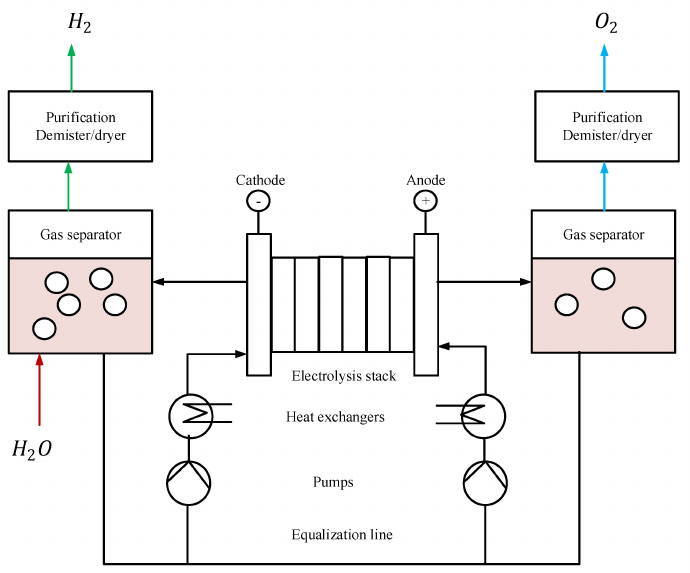
Figure 5. The alkaline water electrolyzer schematic diagram